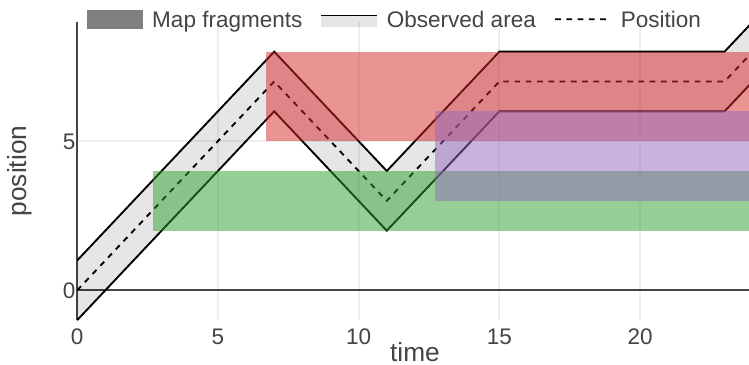
Figure 7. Plot of the agent position and the received map data in 1D. c (cid:13) 2019 IEEE. Reprinted, with permission, from [1].